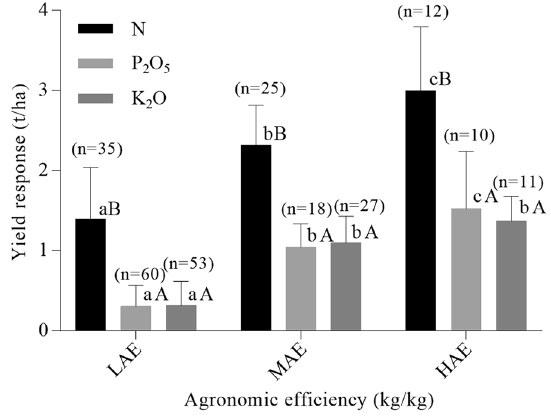
Figure 1. Yield responses (mean ± SD) to N, P 2 O 5 and K 2 O fertilizer applications at low (LAE), medium (MAE), and high agronomic efficiency (HAE). Within each level, different capital letters indicate a significant difference at P < 0.01, whereas among the agronomic efficiency (AE) levels differing lower-case letters indicate a significant difference at P <